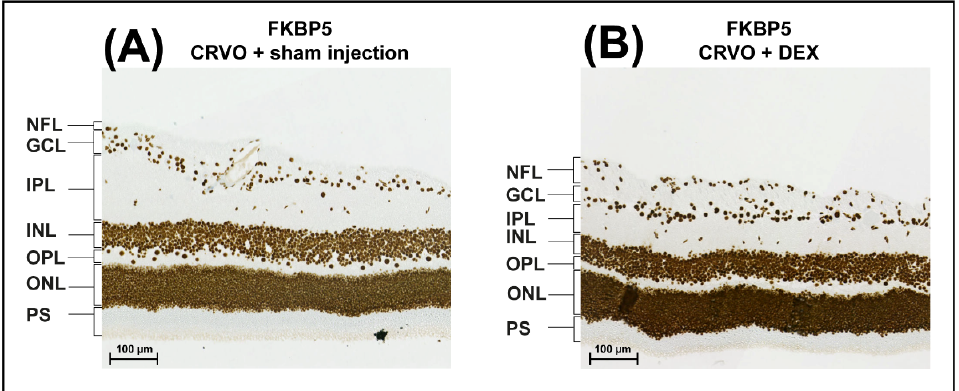
Figure 3. Immunohistochemistry. ( A , B ) Peptidyl-prolyl cis-trans isomerase (FKBP5) was expressed in all retinal cellular layers regardless of DEX treatment. The staining for FKBP5 was stronger following DEX treatment compared with sham injection. The upregulation of FKBP5 was strongest in the nuclei of cells in the inner nuclear layer and the outer nuclear layer. The upregulation of FKBP5 was strongest in the central areas of the retina close to the optic nerve head. Scale bar = 100 µm. Reaction color: brown. Abbreviations: NFL: nerve fiber layer; GCL: ganglion cell layer; IPL: inner plexiform layer; INL: inner nuclear layer; OPL: outer plexiform layer; ONL: outer nuclear layer; PS: photoreceptor segments.